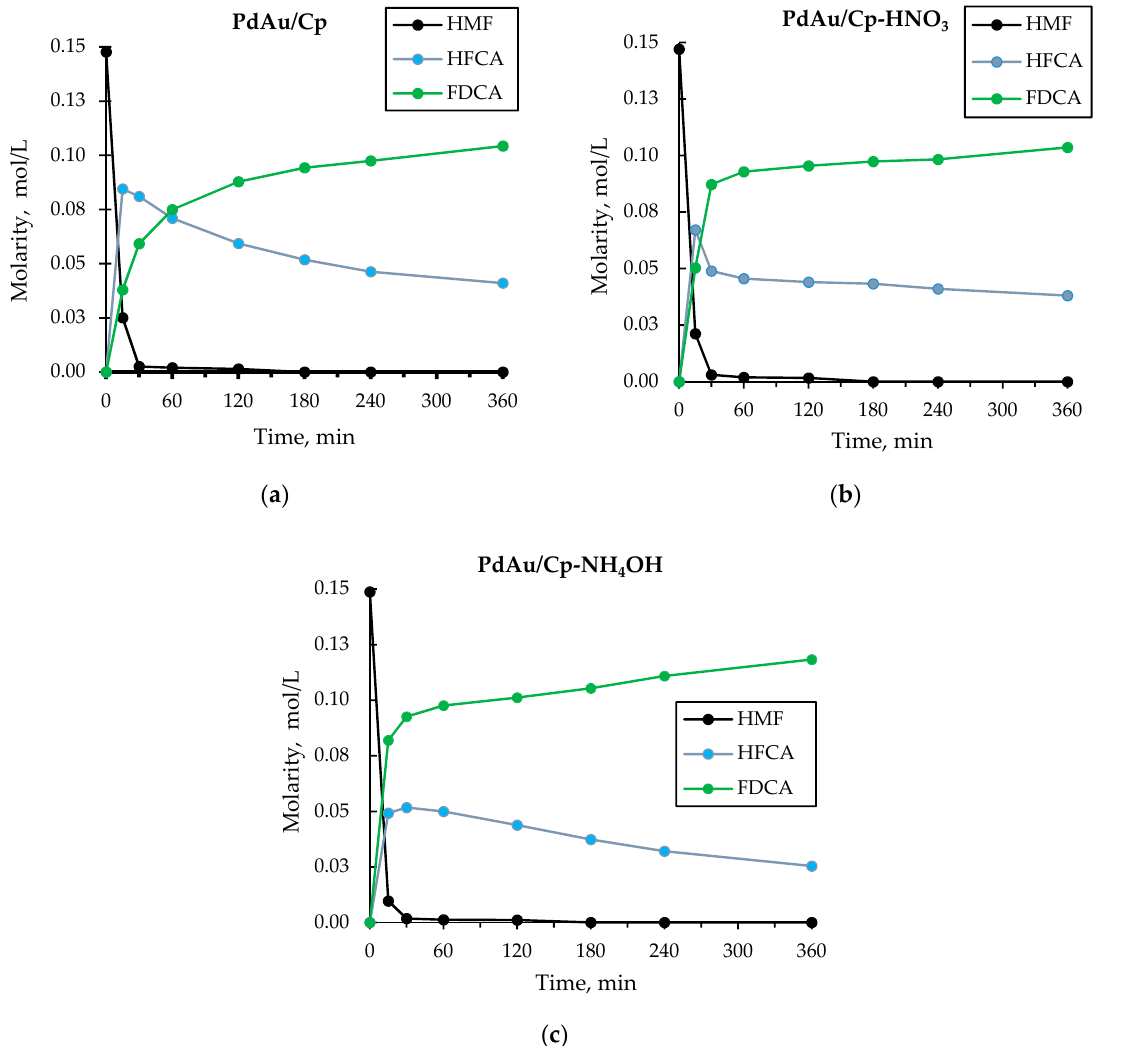
Figure 2. Product distributions in HMF oxidation on gold supported catalysts ( a – c ). Reaction conditions as in Figure 1.